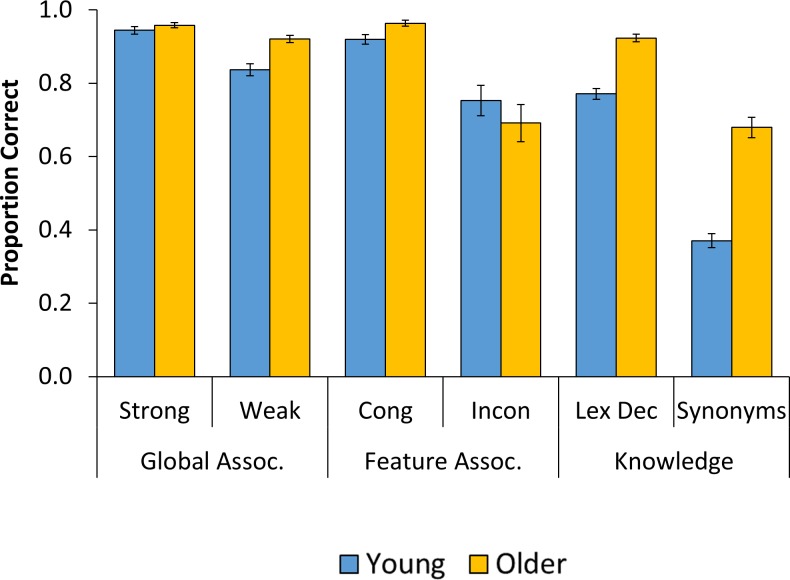
Results of tests of semantic processing.Cong = congruent; Incon = incongruent; Lex Dec = lexical decision.